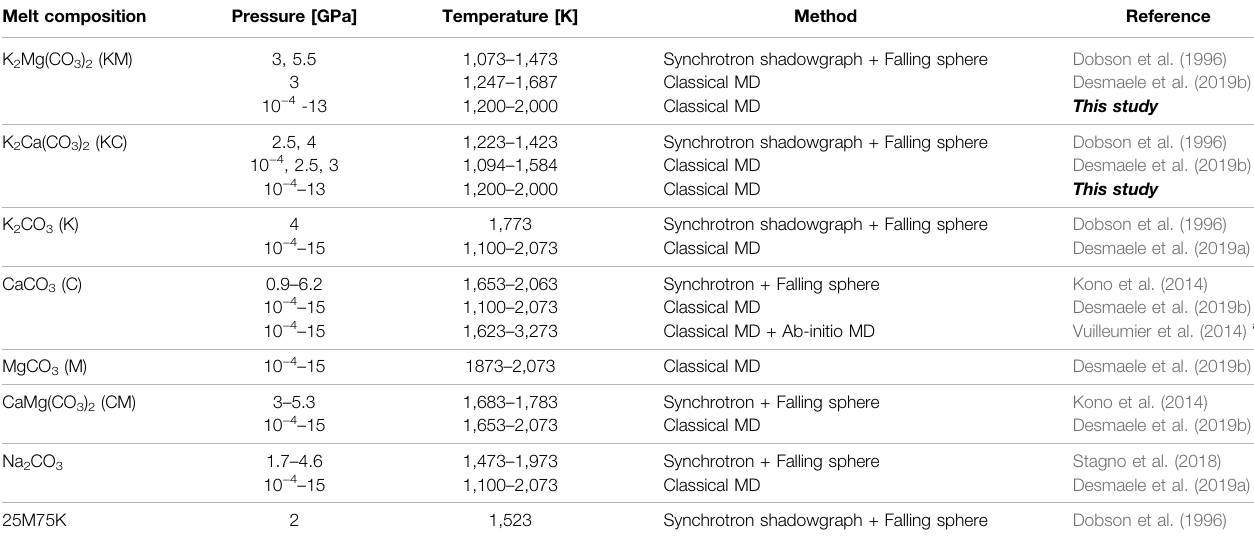
TABLE 1 | Compilation of available high pressure viscosity data for alkali(ne) carbonate melts from experiments and classical/ ab-initio MD simulations. Melt composition Pressure [GPa] Temperature [K] Method